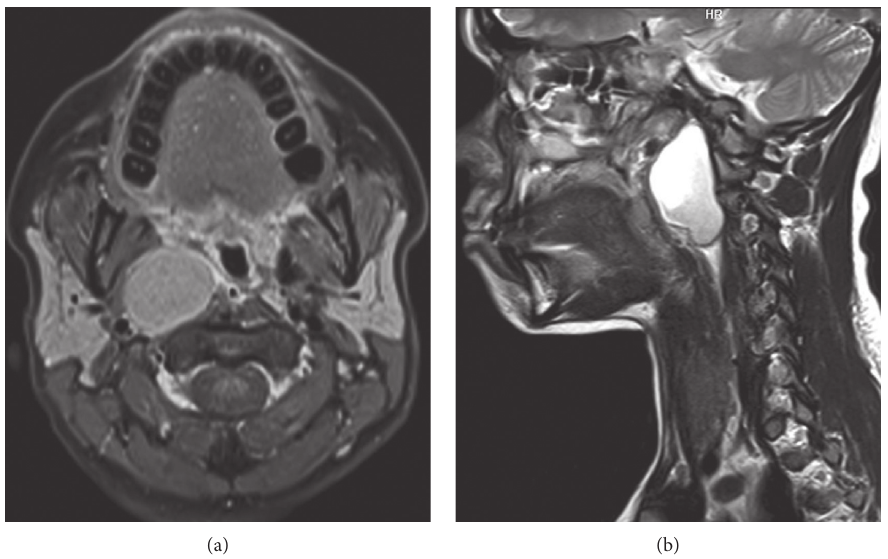
Figure 1: Preoperative magnetic resonance imaging. (a) Axial T1 postcontrast image with fat suppression showing the slightly hyperintense well-defined right parapharyngeal cyst with mild smooth linear wall enhancement and no enhancement of contents, medially indenting nasopharyngeal wall and displacing carotid sheath vessels posterolaterally. (b) Sagittal T2 sequence showing the well-defined cyst extending to skull base and contents heterogeneously hyperintense with fluid-fluid